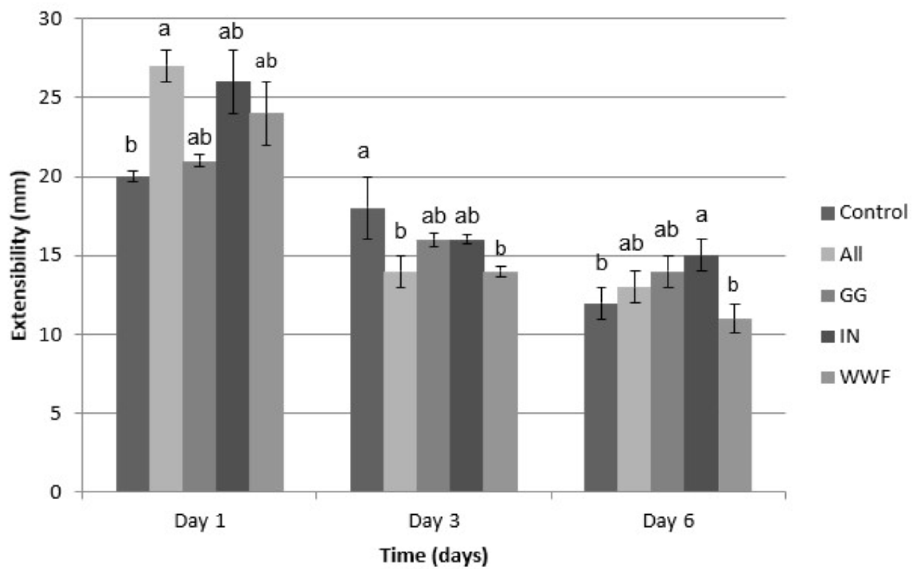
Figure 7. The impact of the added FI on Tandoori breads extensibility (mm). The a and b letters at each sampling time indicate statistically significant differences ( p < 0.05). Values are mean ± SEM of 6